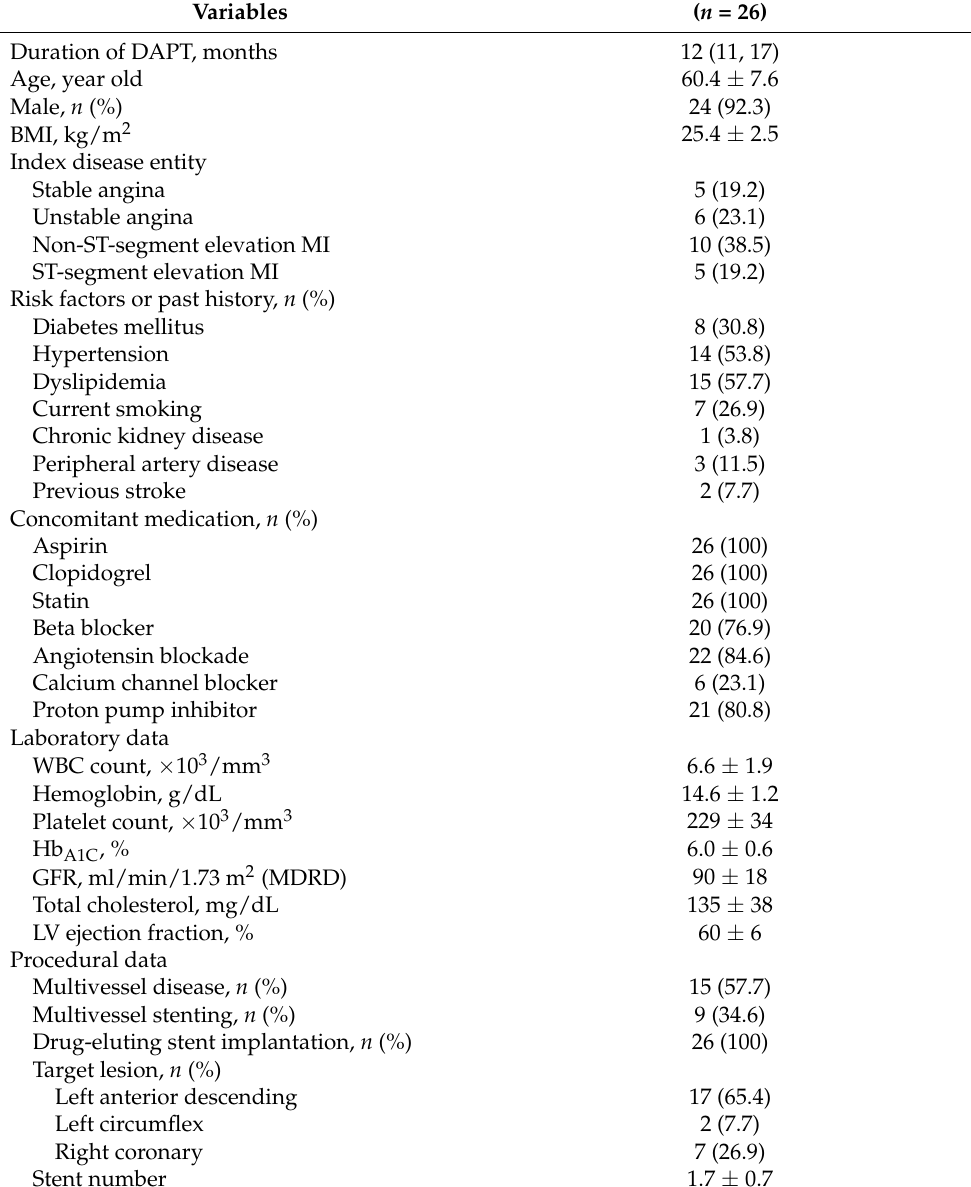
Table 2. Baseline